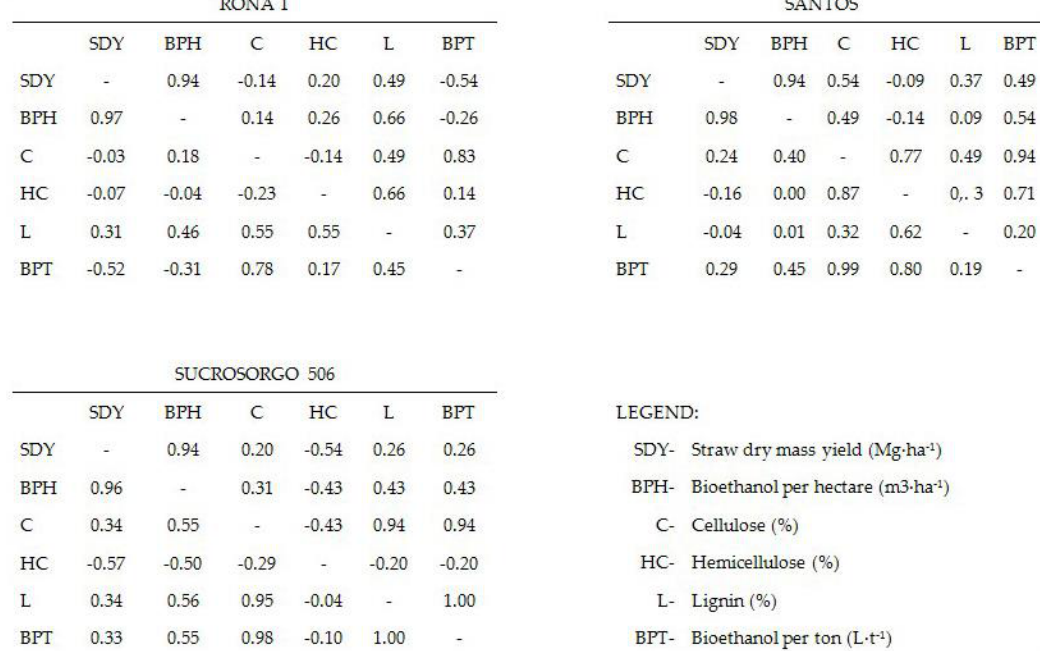
Figure 1. Combined matrices of Pearson correlation coefficients cr p ( lower left ) and Spearman rank correlation coefficients cr s ( upper right ) for the chemical composition and yield of tested varieties.